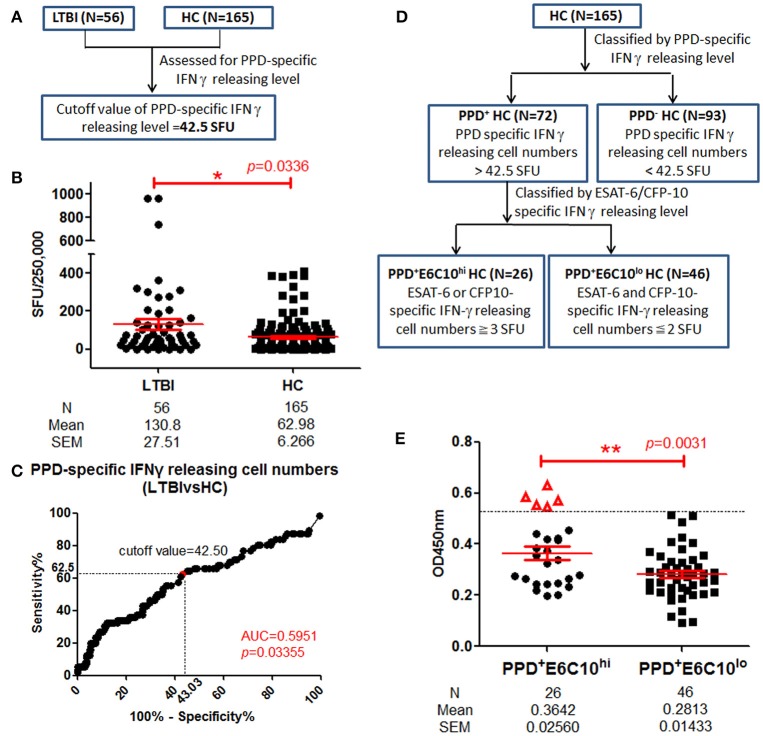
LppZ-specific IgA level in PPD+ HC groups. (A) Flow diagram to define the cutoff value of PPD-specific IFN-γ releasing levels in HCs. (B) PPD-specific IFN-γ releasing cell numbers in LTBI individuals (N = 56) and HCs (N = 165). The P-value was calculated using Mann Whitney test. (C) ROC-curve for PPD-specific IFN-γ releasing cell numbers between LTBI individuals (N = 56) and HCs (N = 165). The cutoff value was calculated using maximal Youden Index. (D) Flow diagram to define PPD+E6C10hi and PPD+E6C10lo HCs. (E) LppZ-specific IgA levels of PPD+E6C10hi HCs (N = 26) and PPD+E6C10lo HCs (N = 46). The P-value was calculated using Mann Whitney test. Δ represents those with higher LppZ-specific IgA level than cutoff value (0.4585). PPD+ HCs: HC individuals with PPD-specific IFN-γ releasing cell numbers > cutoff value (42.5 SFU); PPD+E6C10hi HCs: PPD+HCs with ESAT-6 or CFP-10-specific IFN-γ releasing cell numbers ≧ 3 SFU; PPD+E6C10lo HCs: PPD+HCs with ESAT-6 and CFP-10-specific IFN-γ releasing cell numbers ≦ 2 SFU. *0.01 < p < 0.05, **p < 0.01.